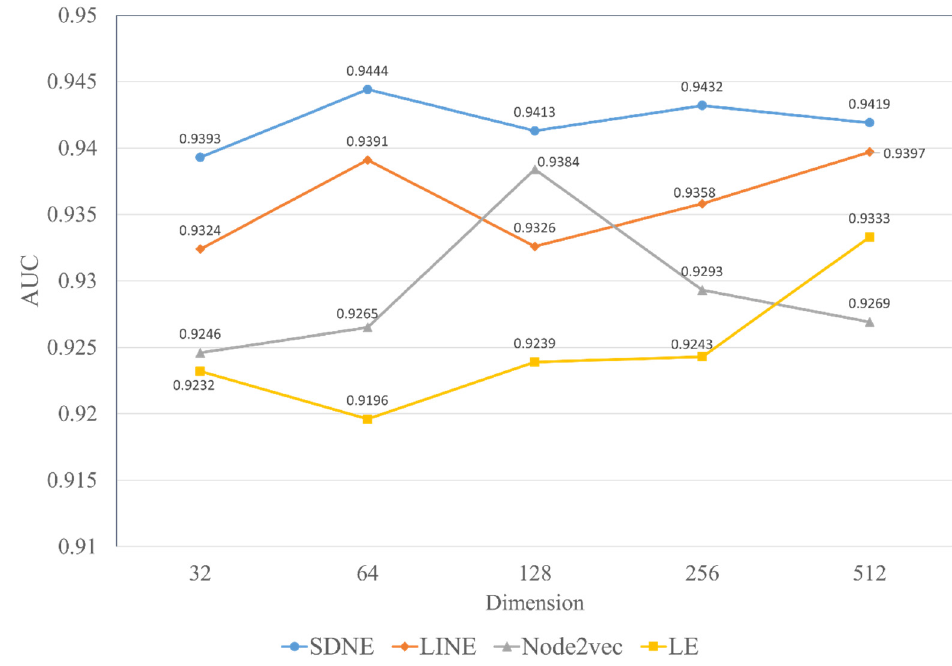
Figure 7. The AUC values of using four network embedding methods in different dimensions.